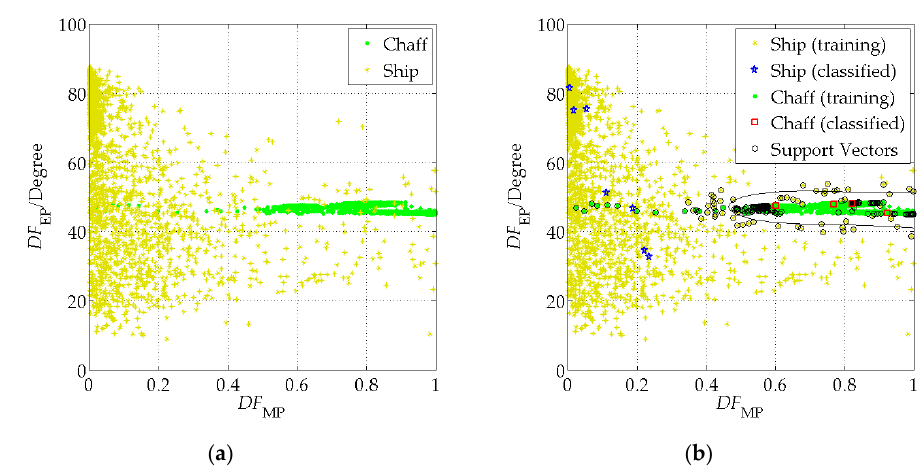
Figure 8. Histograms of DF EP for ships. ( a – g ) T1, T2, T3, T4, T5, T6, and T7, respectively.